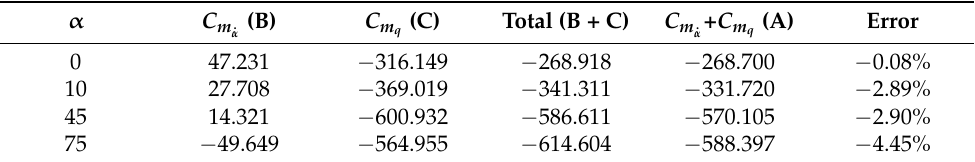
Table 3. Comparison of dynamic stability derivatives of forced pitching (A), forced plunging (B), and forced flapping (C).